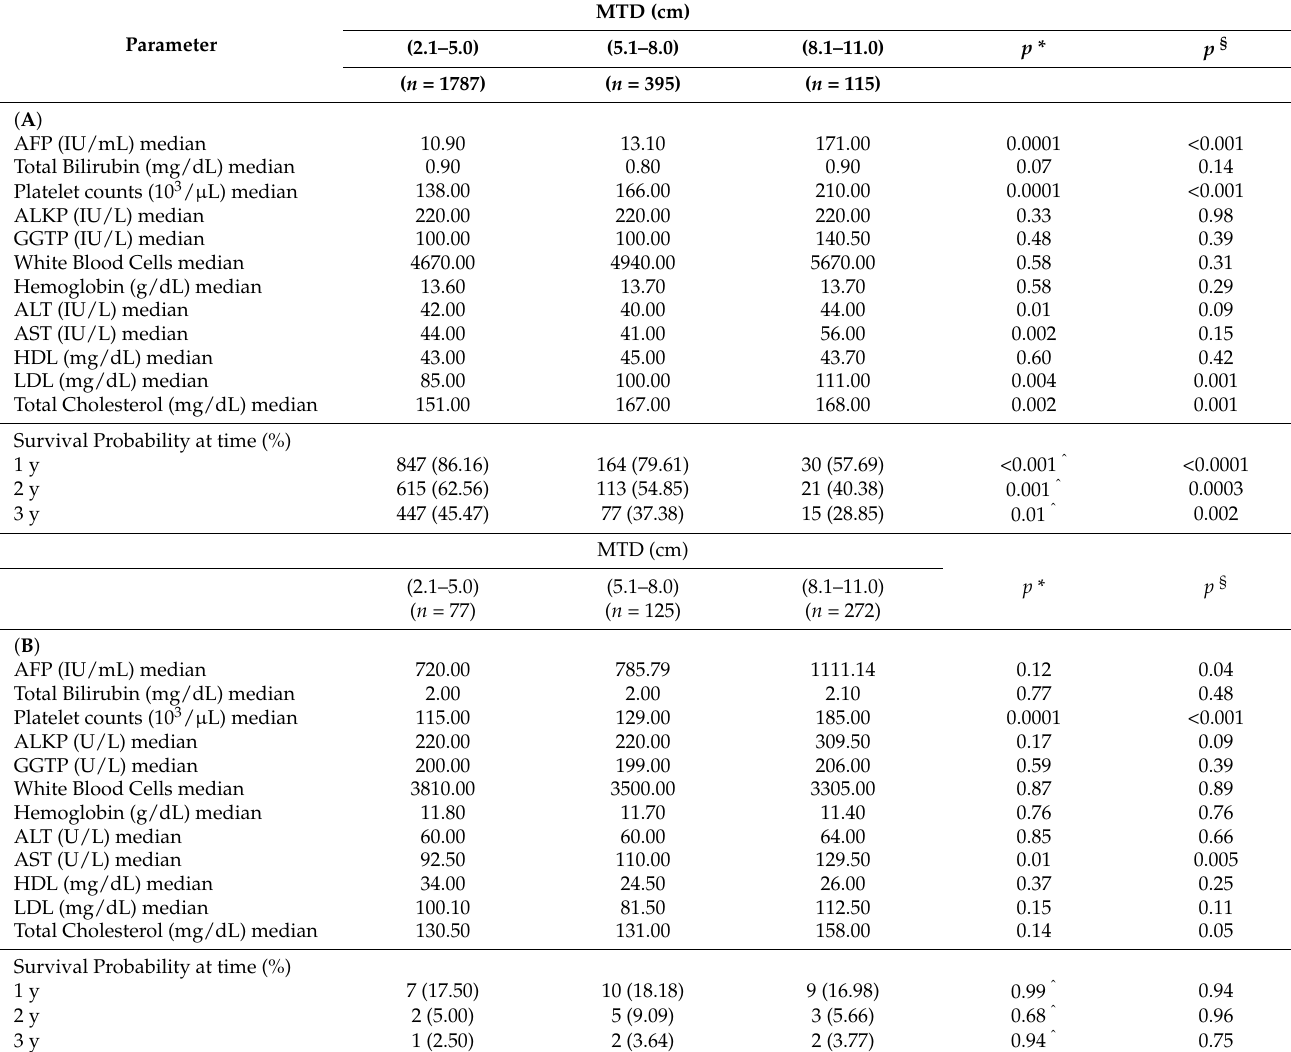
Table 4. Clinical and tumor parameter values subdivided by MTD categories in patients with PVT (negative), nodule number (number ≤ 2), and albumin ≥ 3.5 (g/dL) ( A ), and with PVT (positive), nodule number (number >2), and albumin <3.5 (g/dL) ( B